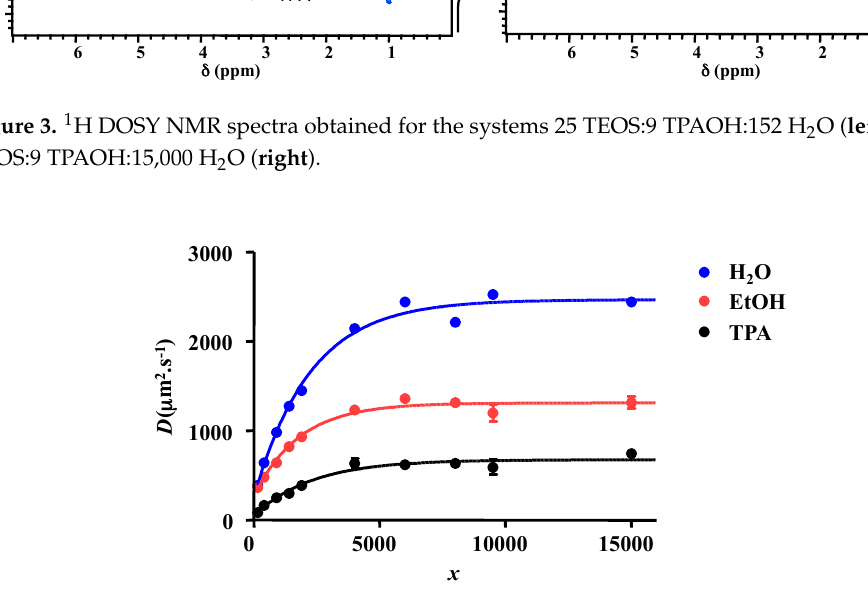
Figure 4. Diffusion coefficients of water, EtOH and TPA species according to 1 H DOSY NMR as a function of water amount in the 25 TEOS:9 TPAOH: x H 2 O system. When absent error bars are smaller than the symbol size and correspond to standard deviation from measurement of individual resonances for a given species.